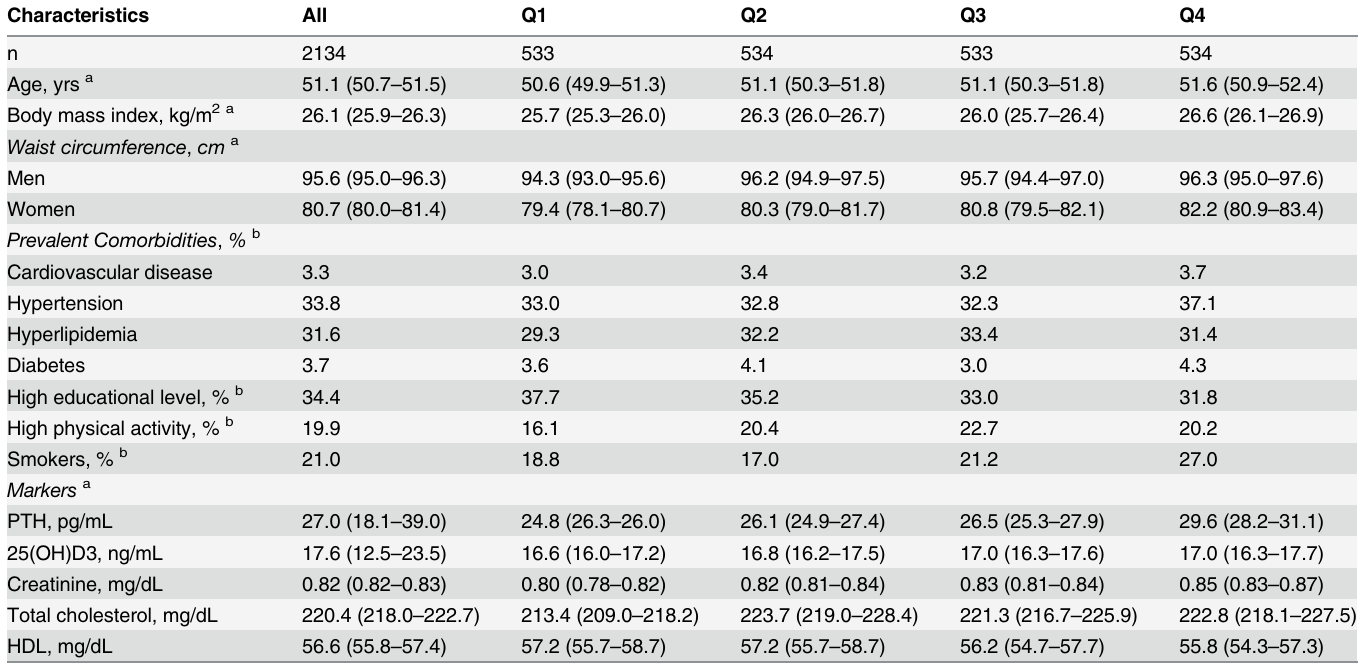
Table 1. Demographic, lifestyle, and clinical characteristics (potential predictors) of EPIC-Germany participants, overall and according to sex spe- cific quartiles (Q) of FGF23 levels.